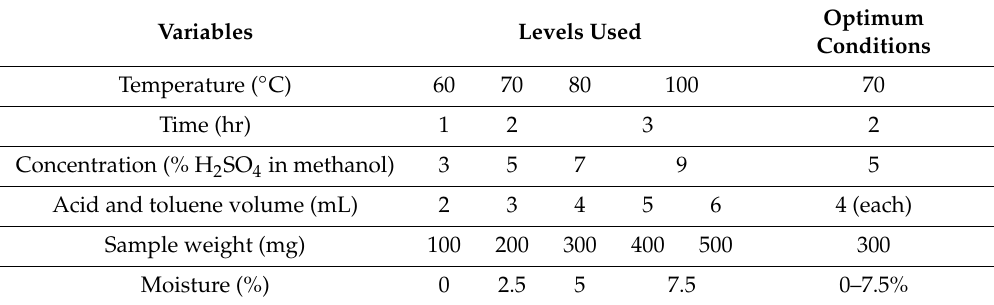
Table 4. Factors and levels used for the experimental